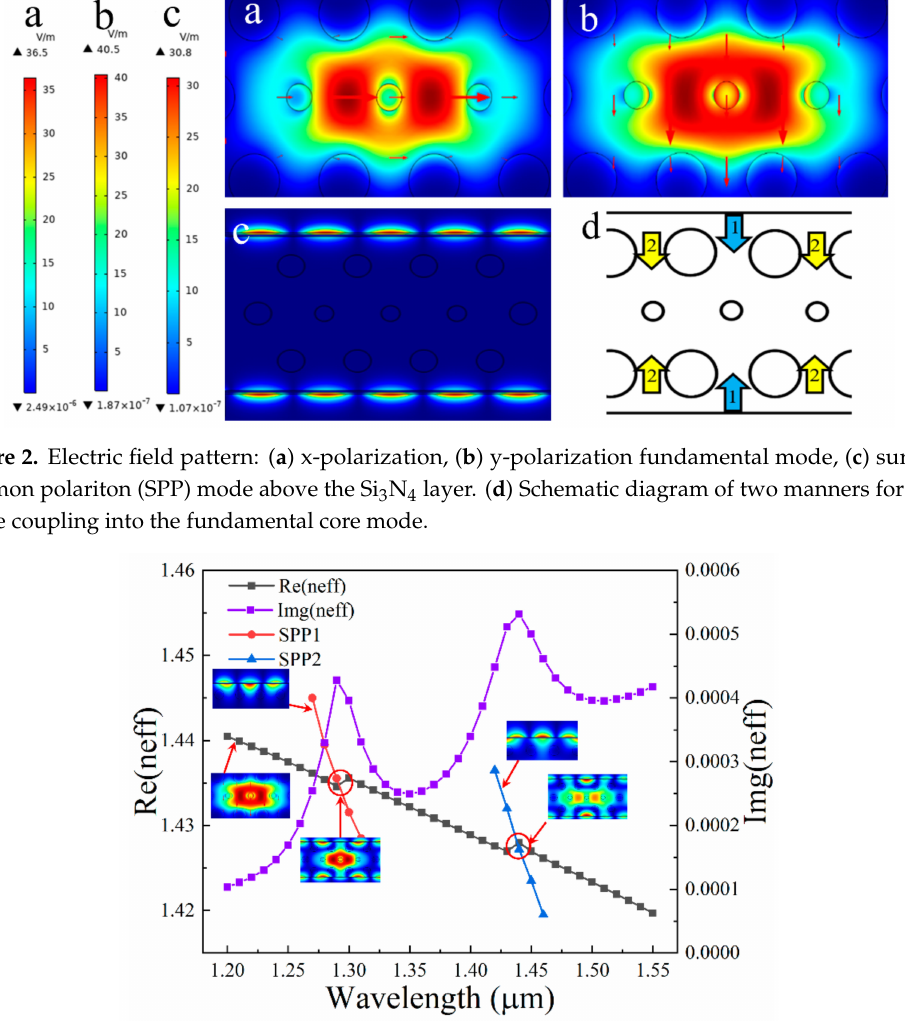
Figure 3. Dispersion relationship between y-polarization fundamental mode and SPP mode for the sensor. Illustrations of electric field distributions at key locations for phase matching are also displayed, when d 1 = 0.70 µ m, d 2 = 0.45 µ m, Λ = 1.60 µ m, t Au = 50 nm, t Si3N4 = 50 nm and n =